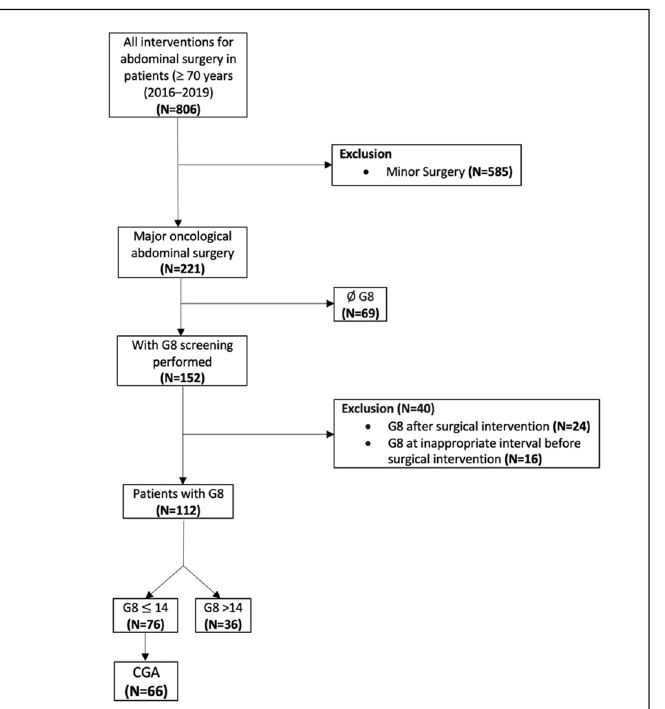
Fig 1. Patients’ flow chart and inclusion